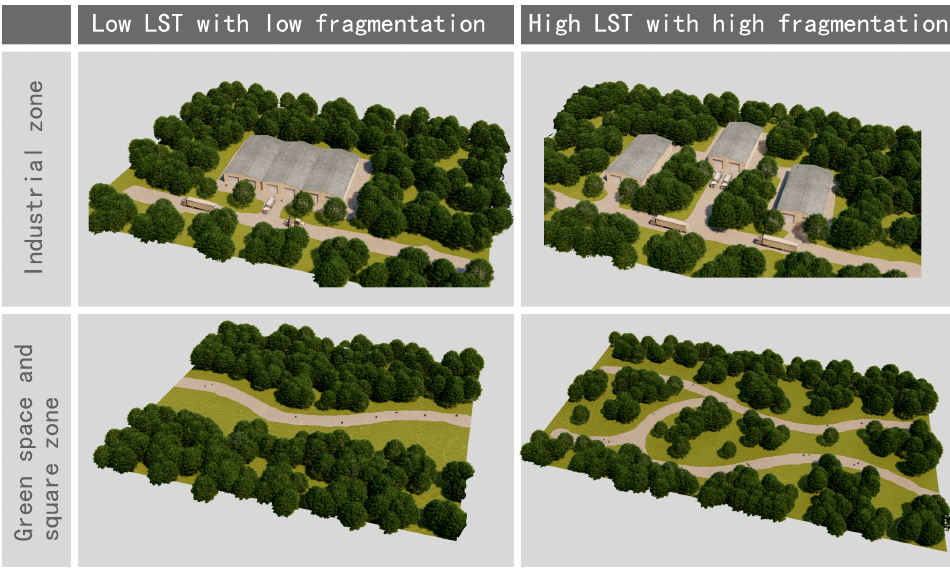
Figure 9. Modification